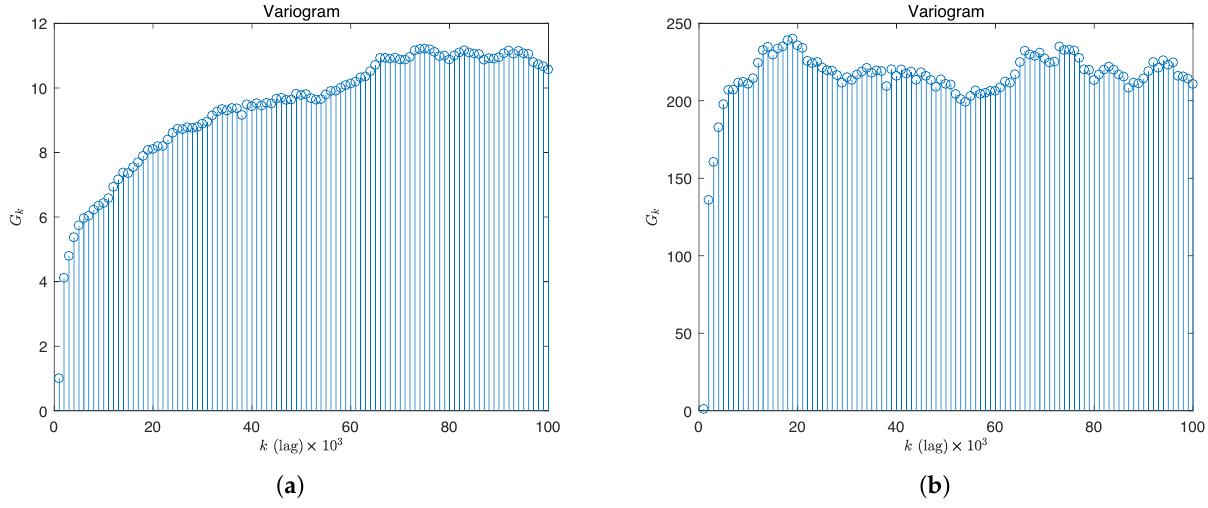
Figure 3. Variogram for the original time series ( a ) and after the non-stationarity removal ( b ). As noted above, pre-processing of a noisy non-stationary signal can impair the MFDFA analysis due to the appearance of crossovers. As an example, it is well known that the Fourier detrending technique, used to eliminate the low-frequency periodicities, generates a crossover and allows us to measure the multifractal characteristics only after a predefined timescale s × , where the scaling function can be approximated with a linear regression [59]. As expected, the normal low-pass filtering procedure based on a linear-phase FIR filter (whose delay group is suitably compensated) also distorts the scaling function for lower scales. With the aim of understanding the dynamic of such distortion, we generated two synthetic signals of 2 15 samples. One was an uncorrelated signal with a Hurst exponent H = 0.5, while the other was a long-range (positively) correlated signal with H = 0.8. The correlated fractional Gaussian noise (fGn) was obtained by the FFT algorithm together with an embedding of the covariance matrix in a circulant matrix—see [61,62]. It is worth noting that, for both signals, the scaling function F q ( s ) is a straight line with an angular coefficient equal to H. In Figure 4, the main findings for the synthetic uncorrelated and correlated signals after the FIR filtering are reported. In Figure 4a,b, the power spectrum estimate after the low-pass filtering is reported. Figure 4c,d gives an idea of the profiles of both signals, while Figure 4e,f report the scaling behavior computed by DFA1. In both cases the wide crossovers around s × = 30 with a bad Hurst exponent are clearly visible, while the scaling behavior remains the original one for s × (cid:29) 30, that is, for asymptotic timescales. This fact has to be taken into account in analyzing pre-processed real-world signals, such as the one at